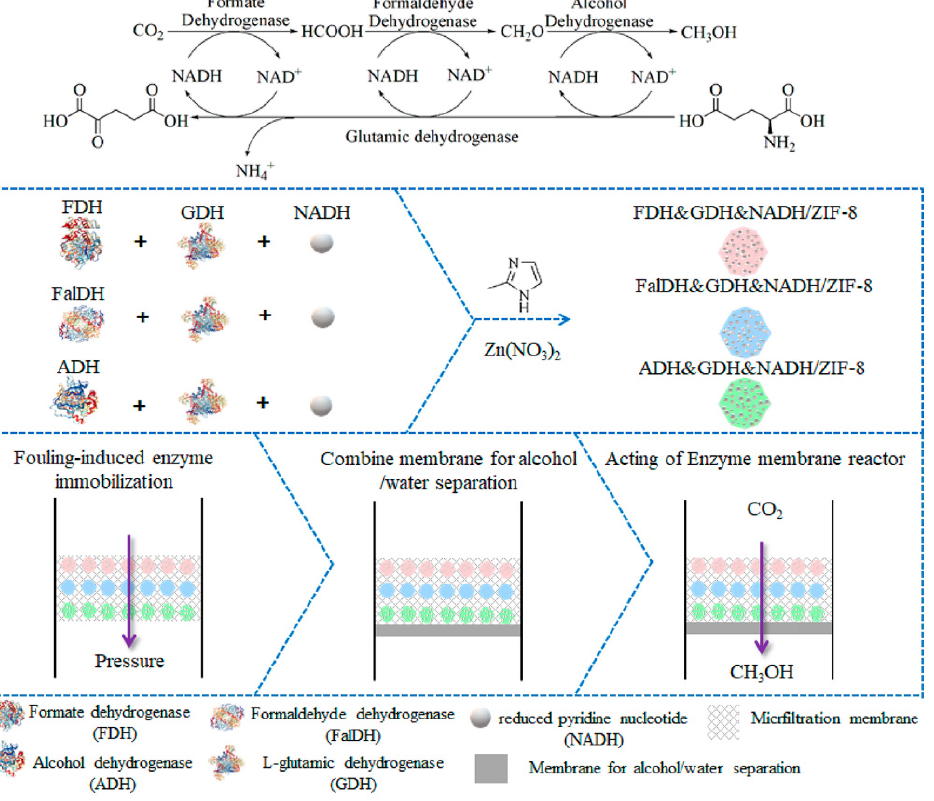
Figure 4. Ordered co-immobilization of a multi-enzyme cascade system with enzymes immobilized in metal organic framework in membrane [42].